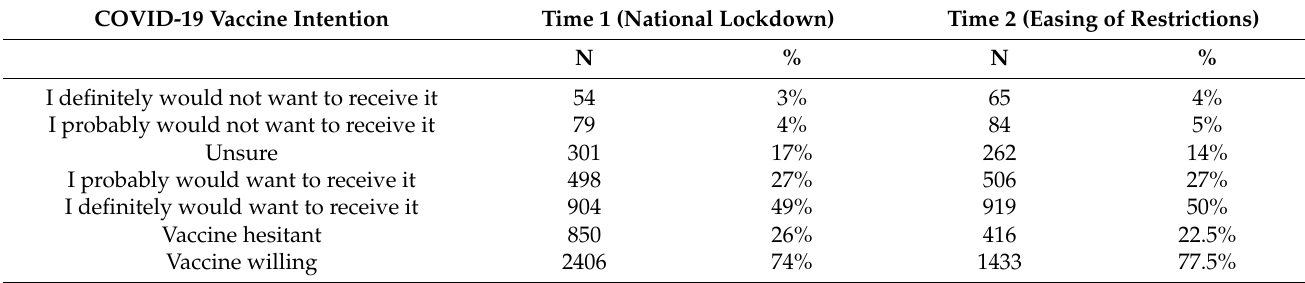
Table 2. Intention to accept a COVID-19 vaccine at Time 1 and Time